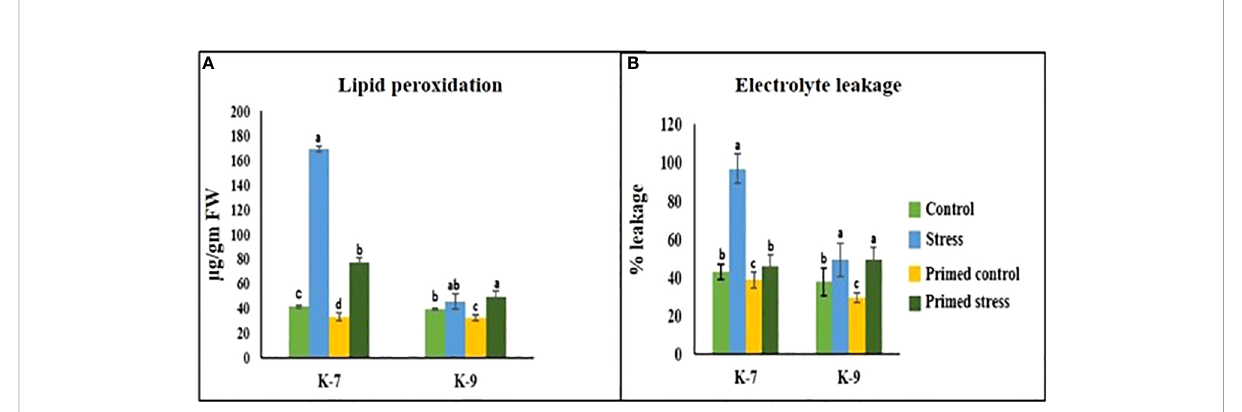
FIGURE 5 Effect of melatonin priming on (A) lipid peroxidation and (B) electrolytic leakage in drought-sensitive (K-7) and drought-tolerant (K-9) varieties with or without drought stress. Data represents mean values ± SD of minimum 3 independent experiments. Different alphabets within the group represent signi fi cant differences among treatments according to Duncan ’ s multiple range test at P <